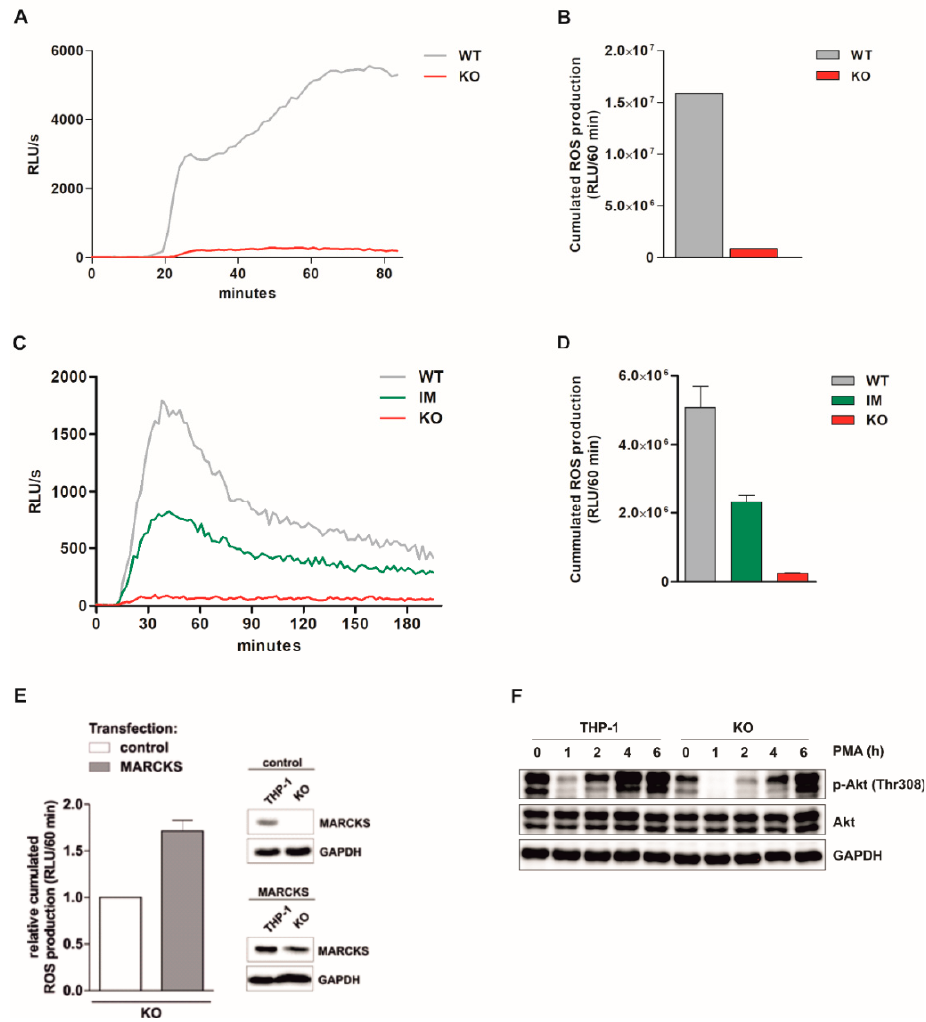
Figure 2. PMA-induced ROS production is suppressed in monocytic MARCKS KO cells. ( A – D ) Monocytic THP-1-derived MARCKS WT and KO clones were differentiated with 100 nM calcitriol for 5 d. ROS production was induced by 100 nM PMA and assessed via luminol-amplified chemiluminescence in relative light units per second (RLU/s). ( A , B ) PMA-induced total ROS production is completely abolished in monocytic MARCKS KO cells. Kinetics ( A ) and the respective cumulated total ROS production (i.e., the area under the curve (AUC) within 60 min following PMA stimulation) ( B ) of total ROS production in MARCKS WT and KO clones (representative experiment, n = 3). ( C , D ) PMA-induced intracellular ROS production is strongly inhibited in MARCKS KO and partially reduced in MARCKS IM cells. Kinetics (( C ), representative experiment) and the respective cumulated intracellular ROS production within 60 min following PMA stimulation (( D ), mean ± SD, n = 3) in WT, IM, and KO clones. ( E ) Reconstitution of MARCKS in KO cells restores PMA-induced ROS production. MARCKS KO clones were differentiated with 100 nM calcitriol for 5 d. At day 3, cells were transfected with a MARCKS-expressing vector or the respective vector control (control cells: THP-1, transfection control: EGFP-encoding plasmid). Cumulated ROS production of EGFP-positive (i.e., transfected) cells within 60 min following PMA stimulation was detected by flow cytometry. The ROS production in control-transfected KO cells was set as 1 (mean ± SD, n = 3). The insets show the MARCKS levels in KO and THP-1 cells transfected with the control or the MARCKS expression vector. ( F ) Basal Akt levels are reduced and Akt re-phosphorylation is delayed in MARCKS KO cells. THP-1 WT and MARCKS KO cells were treated with 100 nM PMA. At the indicated time points, cells were harvested, and total cell extracts were prepared. Akt phosphorylation (at Thr308) and total Akt levels were determined via Western Blot (loading control: GAPDH; representative experiment, n =